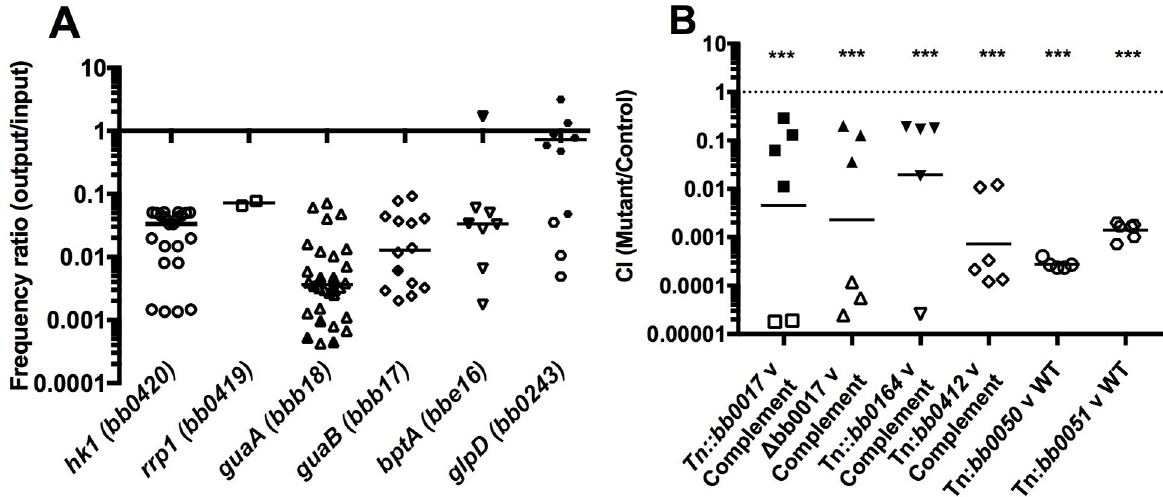
Fig 2. Fitness of selected genes required for Borrelia burgdorferi survival in larval ticks. (A) Frequency ratios of individual Tn mutants with insertions into the indicated genes known to be important in B . burgdorfer i survival in the tick. The frequency ratios of individual Tn mutants with insertions in these genes are shown for both replicates. The median is indicated with a bar. An open shape indicates that no reads were recovered for this mutant and for the purposes of calculation the read number was set to one. (B) Individual Tn mutants were mixed in a one to one ratio with the parental strain 5A18NP1 or the respective complemented strain, and the mixtures were used to infect larvae. After a blood meal these larvae were crushed and plated with appropriate antibiotics to distinguish between the Tn mutant and the complemented strain (or parental strain). Competitive Indices (CI) were determined. Closed shapes indicate that the Tn mutant was recovered following the competition experiment. Open shapes indicate no Tn mutants were recovered following competition experiment. In these cases, the number of Tn mutants recovered was set to one for the purposes of calculation. Statistical significance was determined by one sample t test ( ��� , P < 0.0001). (Statistics performed on GraphPad Prism version 7, GraphPad Software, LaJolla